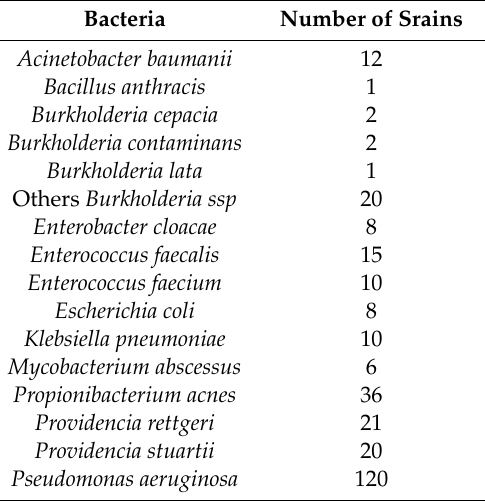
Table 2. Target bacteria collection.